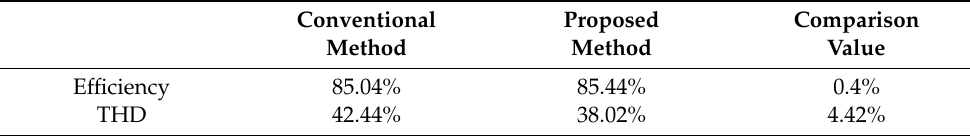
Figure 10. Operation waveform at light load (10%). ( a ) conventional synchronous PWM method and ( b ) the proposed synchronous PWM method. Table 3. Comparison of experimental results between the conventional and the proposed